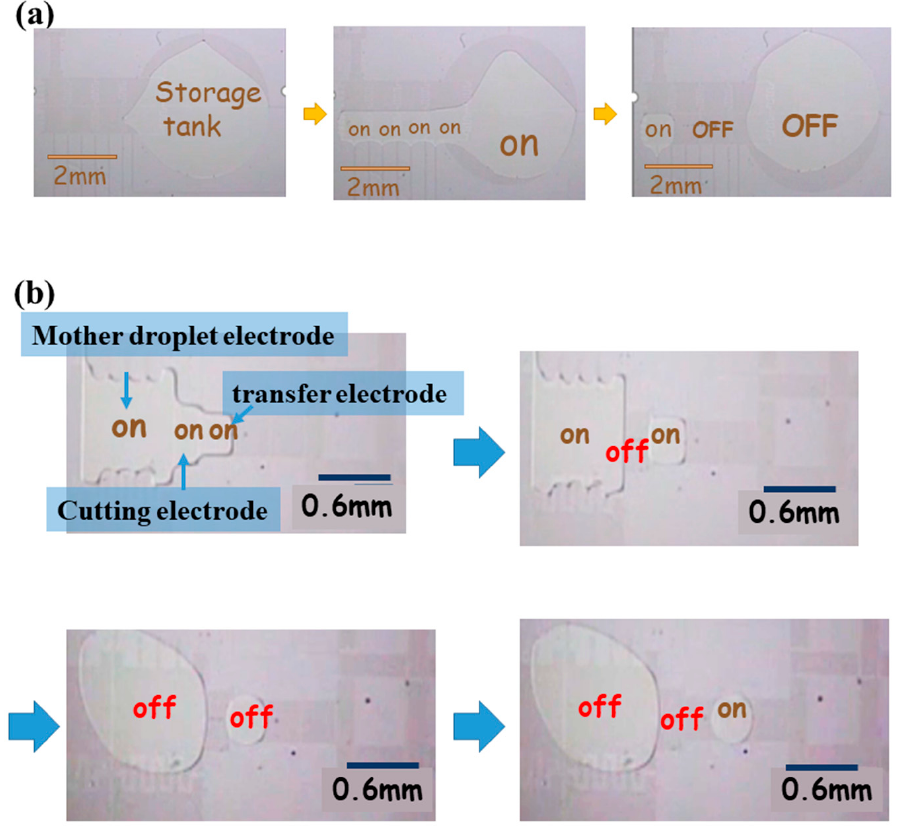
Figure 5. Droplet generation; ( a ) mother droplet generation; ( b ) droplet generated and moving forward from a mother droplet.